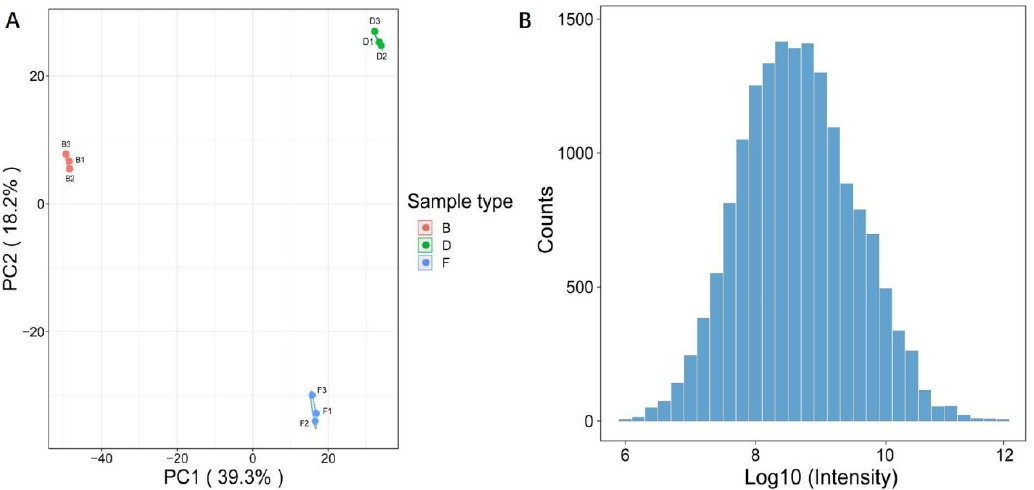
Figure 2. Experimental strategy for quantitative proteome analysis and quality validation. ( A ) PCA analysis of protein quantitation among each sample; ( B ) histogram of proteomics data. B — Control; D — L. monocytogenes 10403s ; F — L. monocytogenes M7.